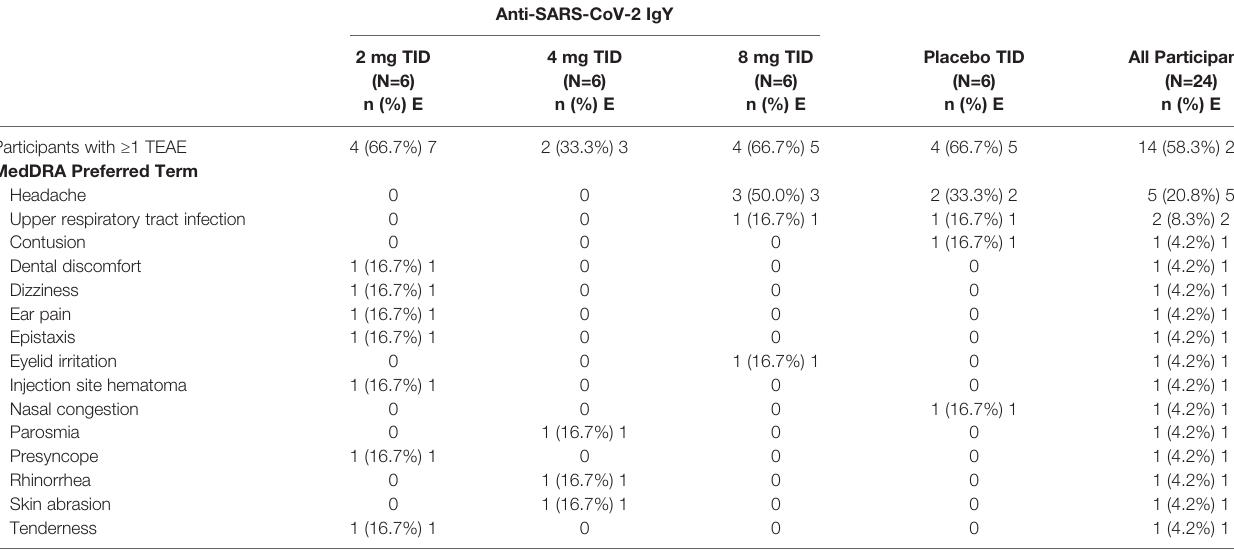
TABLE 4 | Adverse events by preferred term- multiple-dose study (Part